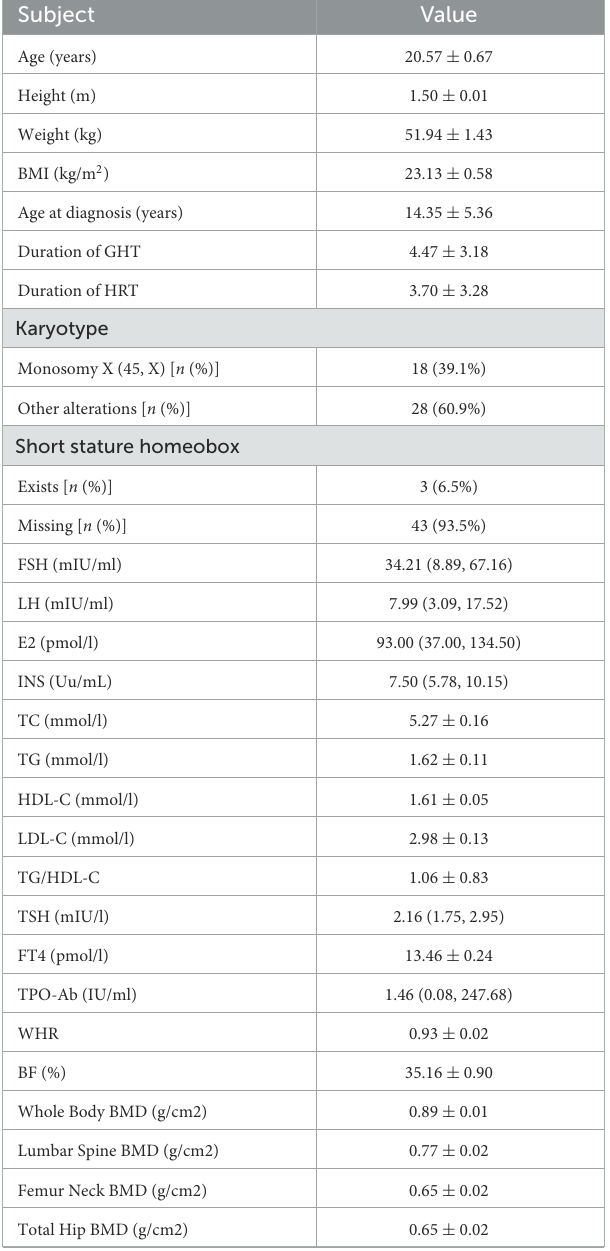
TABLE 1 Clinical characteristics of the study